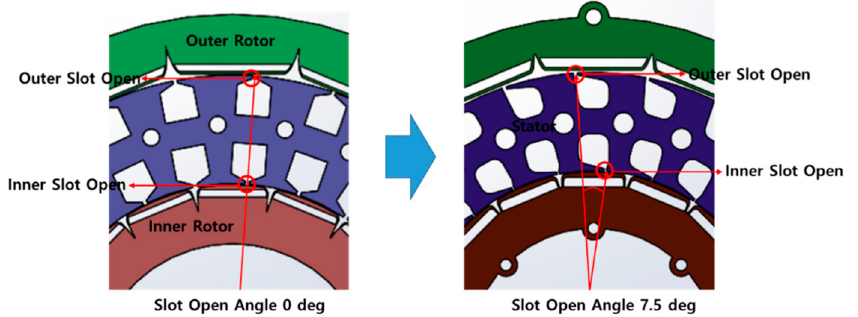
Figure 11. Adjustment of stator slot opening angle.